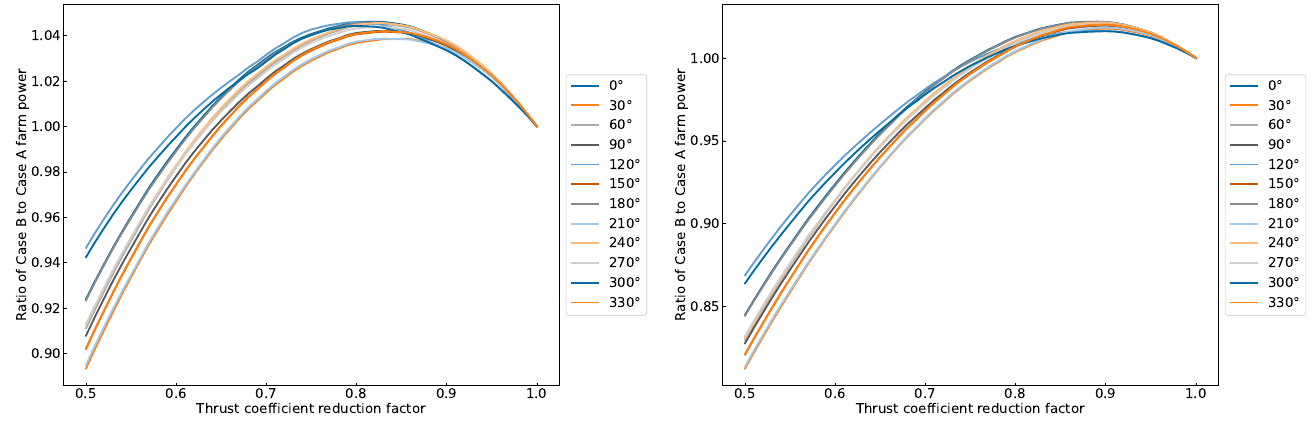
Figure 15. Impact of C T reduction on the wind farm power (relative to Case A) at 12 different wind directions with a fixed natural wind speed of U F 0 = 10 m/s, for two different wind extractability scenarios: ζ = 10 ( left ) and 20 ( right